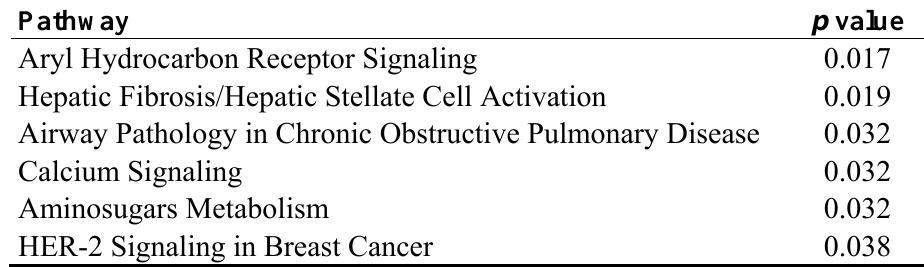
Table 2. Canonical pathways enriched within the AML Signalisome.